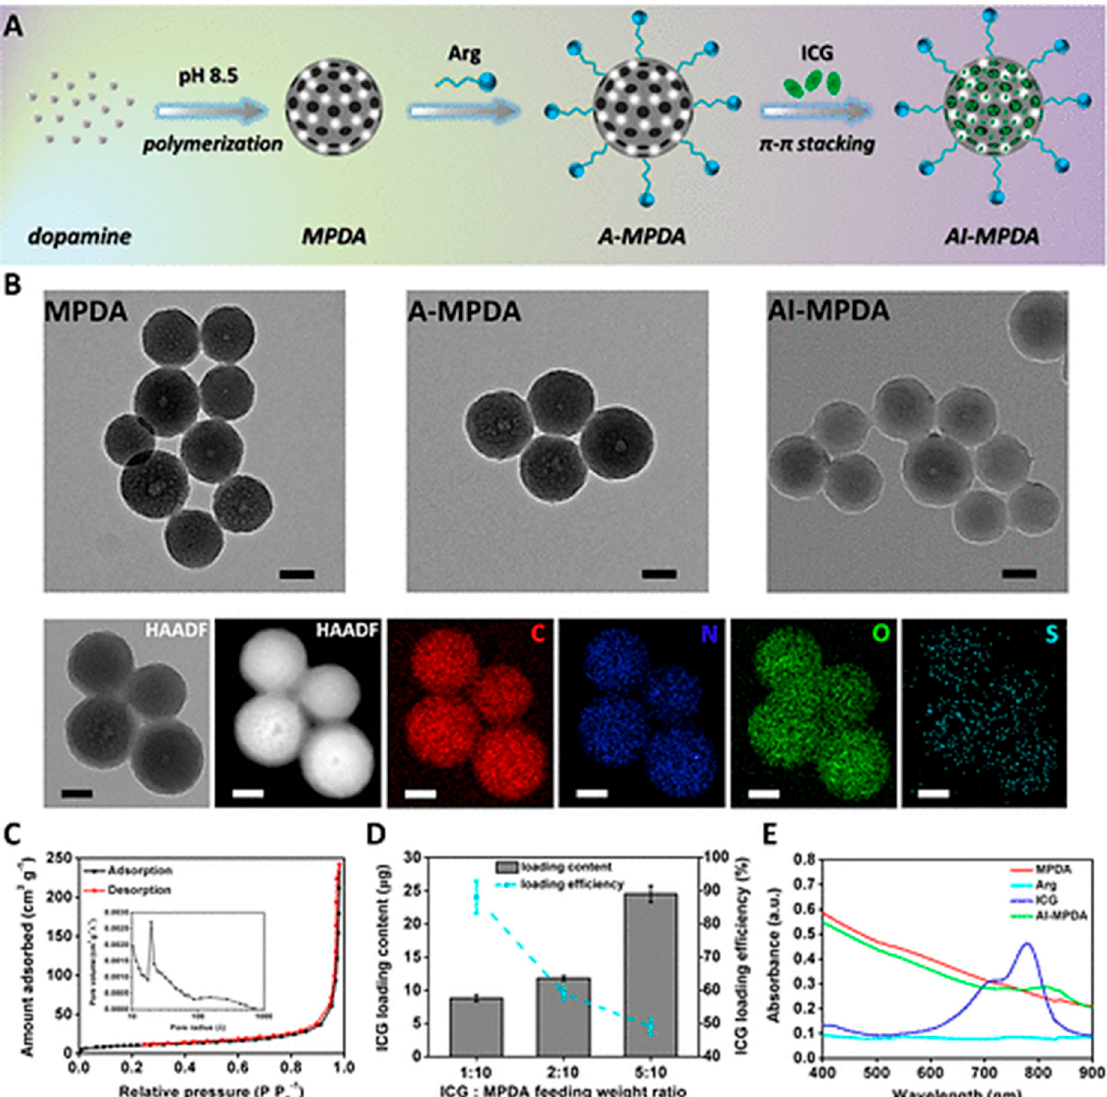
Figure 8. ( A ) Schematic illustration showing the preparation of hybrid PDA NPs consisting of l-arginine (l-Arg, A), indocyanine green (ICG, I), and mesoporous PDA (MPDA). ( B ) Representative TEM micrographs of different NPs, high-angle annular dark-field scanning transmission electron microscopy image of hybrid PDA NPs, and corresponding elemental mapping (scale bar: 100 nm). ( C ) N 2 adsorption/desorption isotherms and pore-size distribution (inset) of MPDA NPs. ( D ) ICG loading content and efficiency in AI-MPDA NPs at different ICG:A-MPDA feeding weight ratios (0.1 mg of A-MPDA). ( E ) UV/vis absorbance spectra of MPDA (0.1 mg mL − 1 ), Arg, ICG (5 μ g mL − 1 ), and AI-MPDA NPs (0.1 mg mL − 1 ). From reference [132] Reprinted with permission from the American Chemical Society.